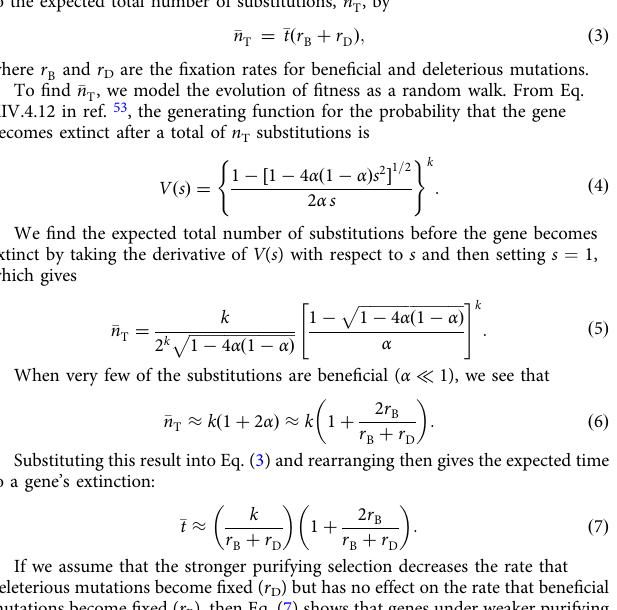
ffiffiffiffiffiffiffiffiffiffiffiffiffiffiffiffiffiffiffiffiffiffiffiffiffiffiffi (cid:2) 1 (cid:2) 4 α ð 1 (cid:2) α Þ